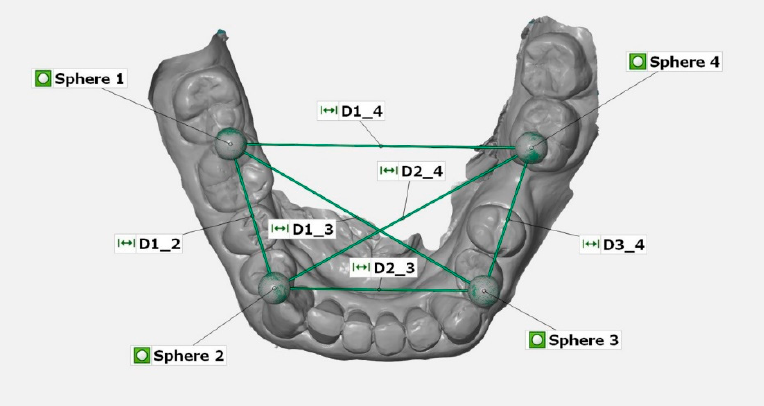
Figure 3. Example of the measurement of linear distances (D1_2, D1_3, D1_4, D2_3, D2_4, D3_4) between the centers of the four spheres 1–4 (top view of STL dataset in GOM software).